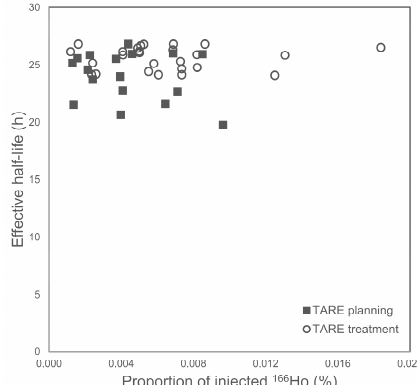
Figure 7. Correlation between effective half-life and excreted activity of 166 Ho after TARE planning (24 h) and TARE treatment (48 h) procedures.